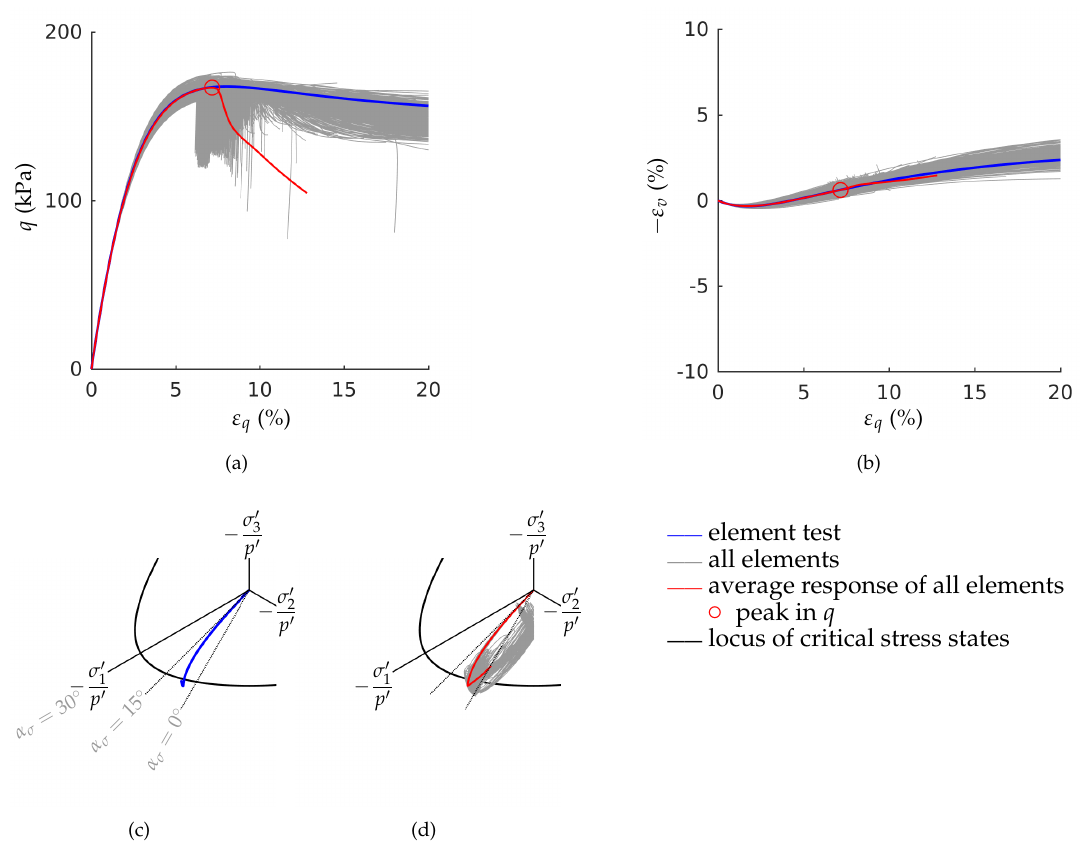
Figure 16. OCR = 6: ( a ) Deviatoric strain ε q -deviatoric stress q plot; ( b ) Deviatoric strain ε q -volumetric strain ε v plot; ( c , d ) Stress paths for OCR = 6 in the deviatoric plane normalized with the mean effective stress p (cid:48)